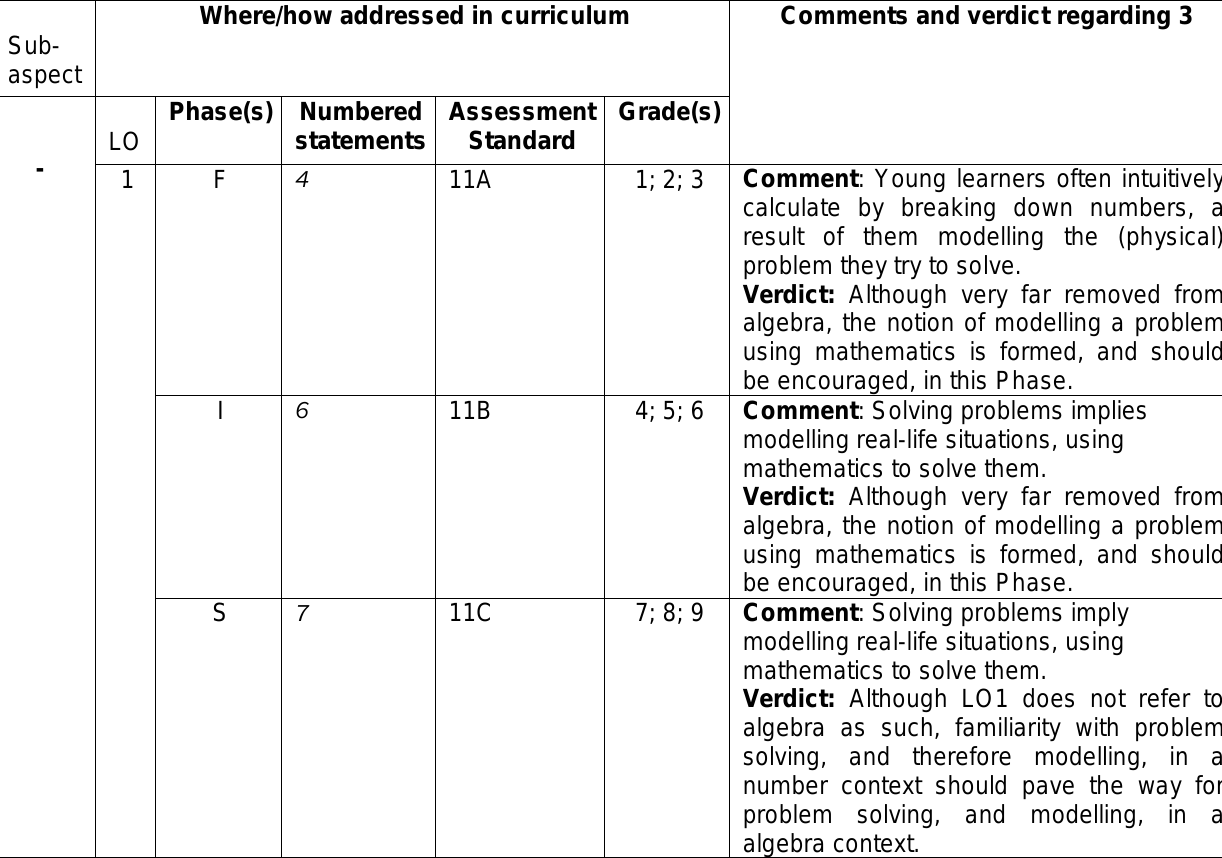
Table 11. Aspect 3: enable learners to use and appreciate algebra as a tool to solve problems inside and outside mathematics, often through a modelling process (LO1).